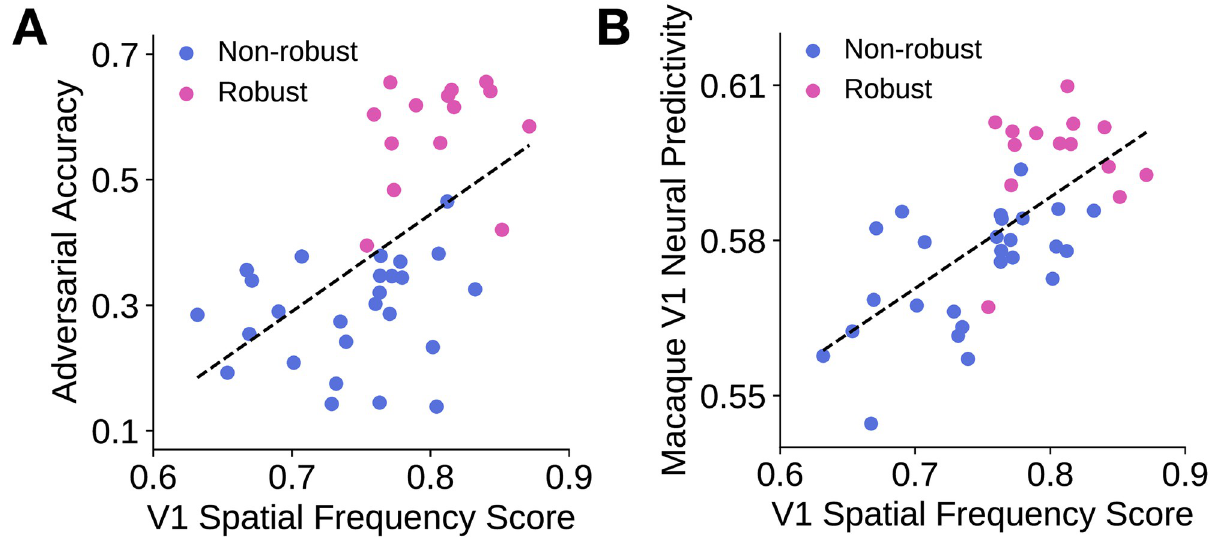
Fig 7. V1 spatial frequency score is somewhat correlated with adversarial accuracy and is correlated with V1 neural predictivity. Each model is represented by a dot in each subfigure, with blue denoting non-robust models and pink denoting robust models. Dashed line indicates the line of best fit through the data points. A . A model’s adversarial accuracy is plotted against its V1 spatial frequency score, which denotes the similarity between a model’s preferred spatial frequency distribution and that of macaque V1 cells. R = 0.544, p < 0.001. B . A model’s maximum macaque V1 neural response predictivity is plotted against its V1 spatial frequency score. R = 0.663, p < 0.001.